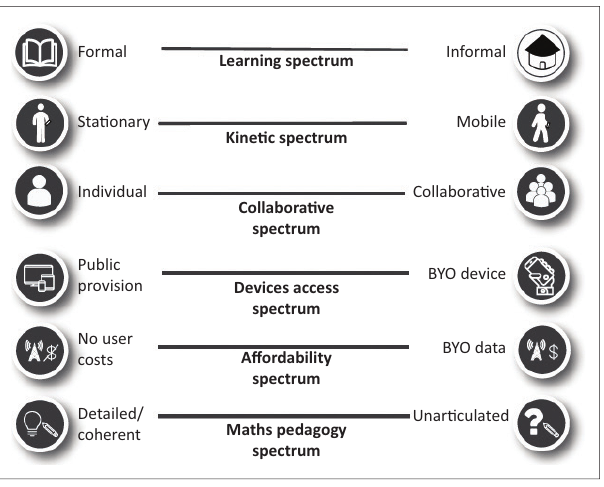
FIGURE 1: Analytical framework for m-learning